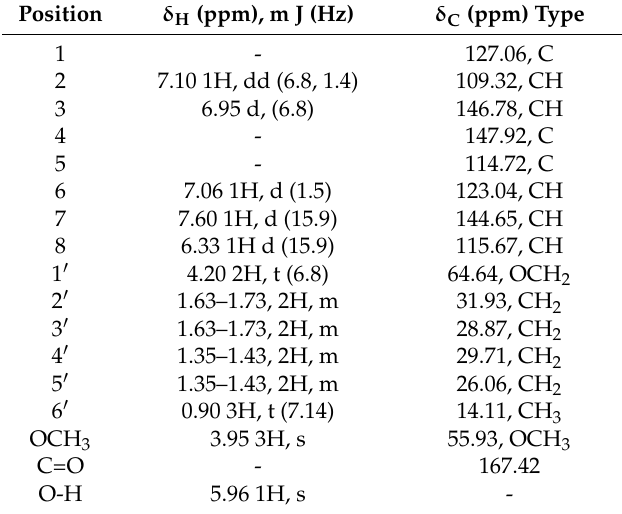
Table 4. 1 H-NMR (600 MHz) and 13 C-NMR (150MHz) in CDCl 3 spectra data of FEQ-2.